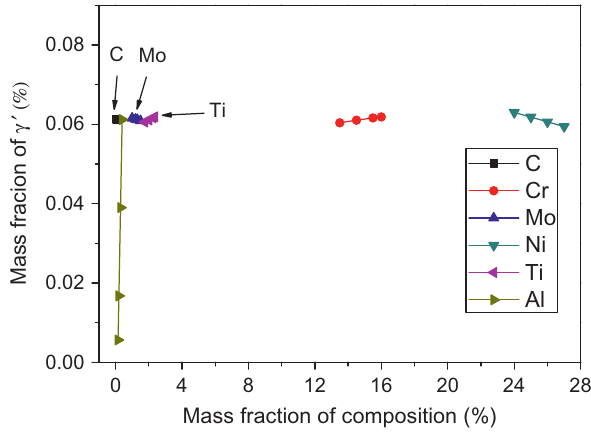
Figure 10: Influence of different elements on maximum amount of γ ′ phase.